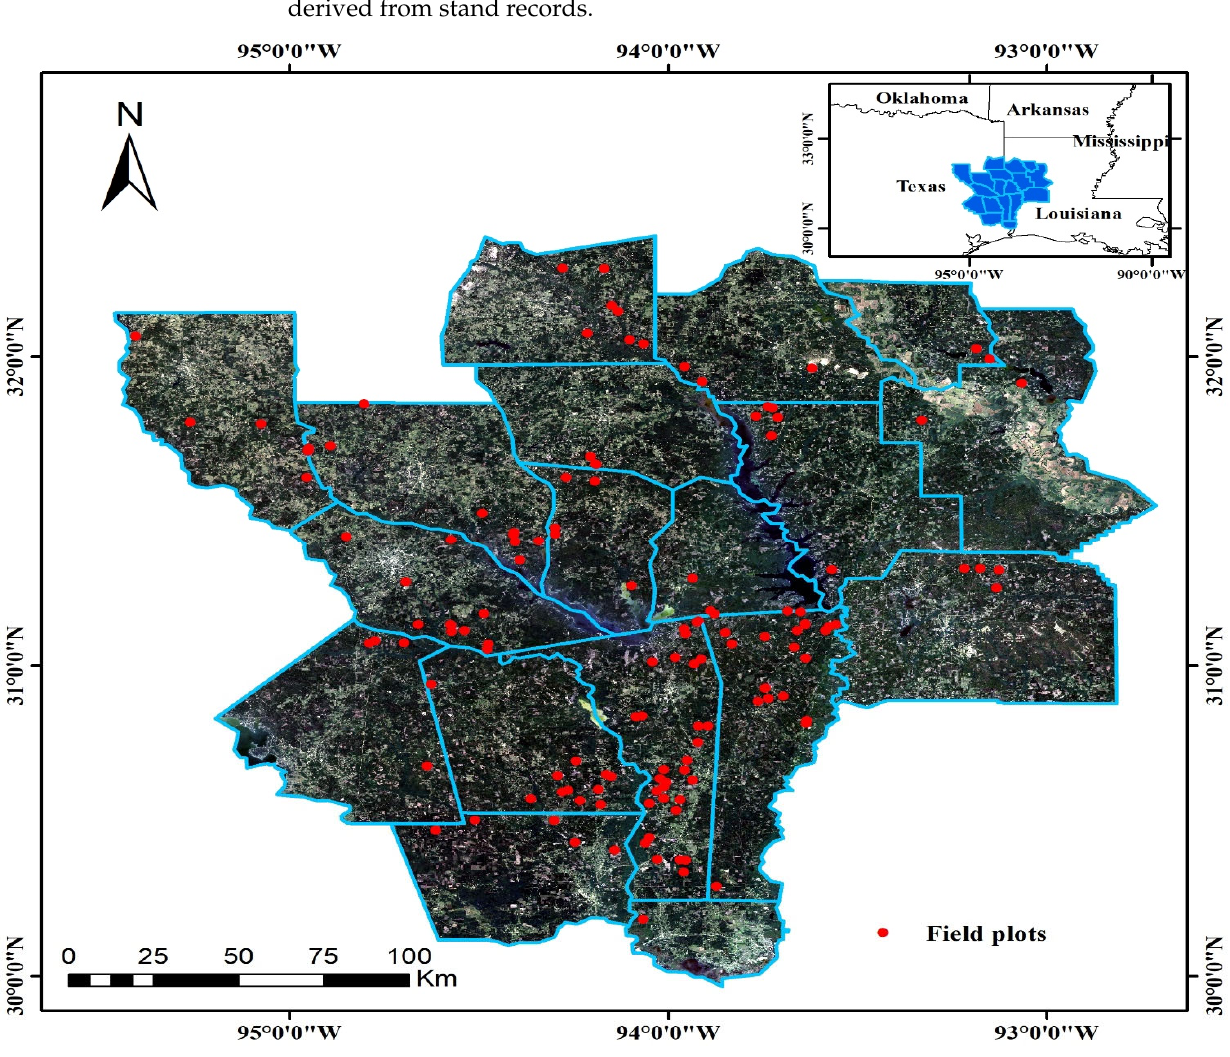
Figure 1. Geographic location of field permanent plots of loblolly plantations.